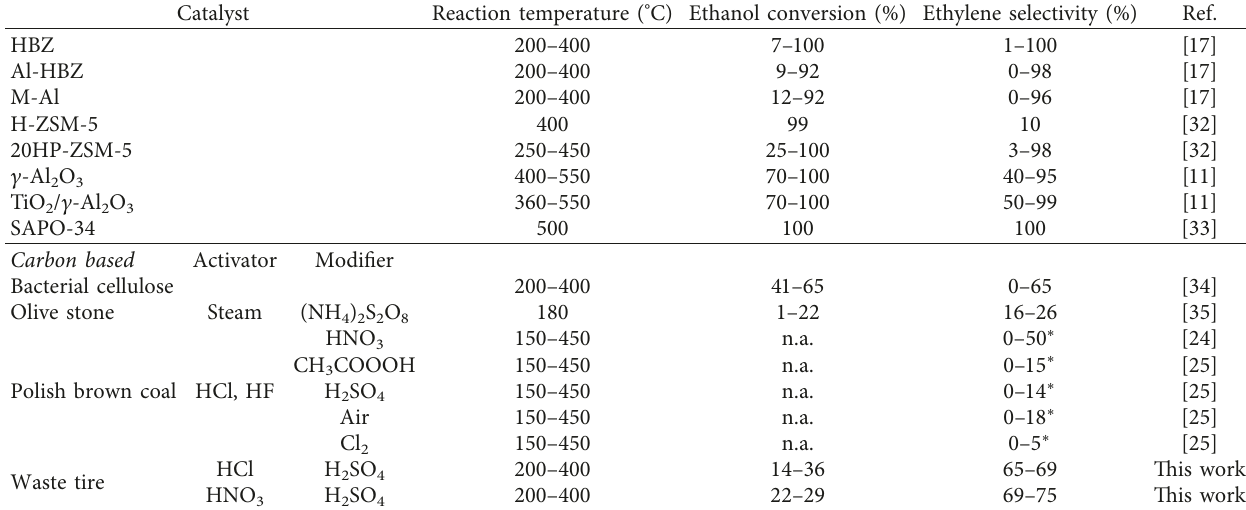
Table 4: Comparison of catalysts for ethylene dehydration and their catalytic